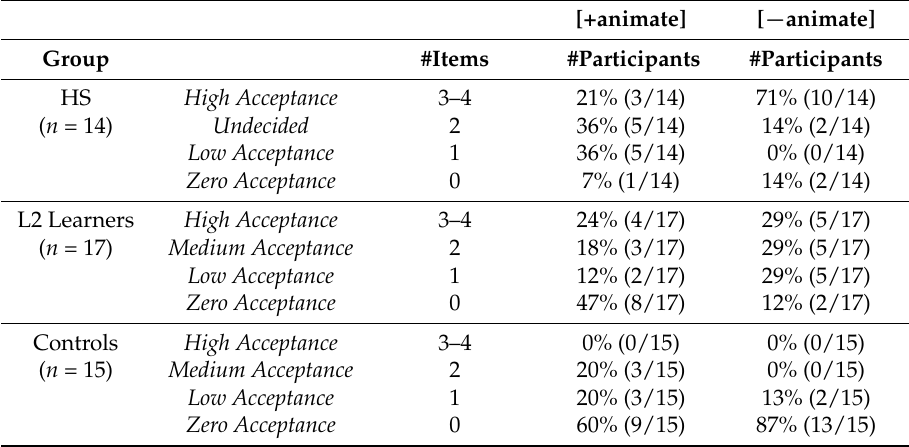
Table 4. AJT: proportion of acceptance of ungrammatical items in SIMPLE sentences.